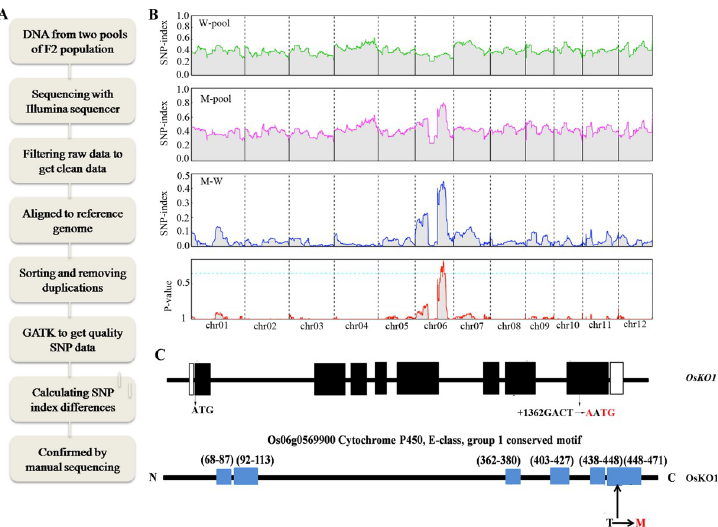
Fig 2. Characterization of the mutations through whole-genome resequencing and mutmap methods. (A) flowchart of the sequencing-based method. (B) Whole-genome resequencing of mutant and Nipponbare wild-type segregant F2 population to get casual mutations. Scrolling window plots show SNP index of sequencing results from wild-type pool, mutant pool and SNP index differences with their p values by chi-squared test and fisher test on 12 chromosomes. (C) Structure and mutation sites of OsKO1 gene and its corresponding protein. Black boxes indicate exons, white boxes are UTRs, red fonts are mutated nucleotids and corresponding amino acids.